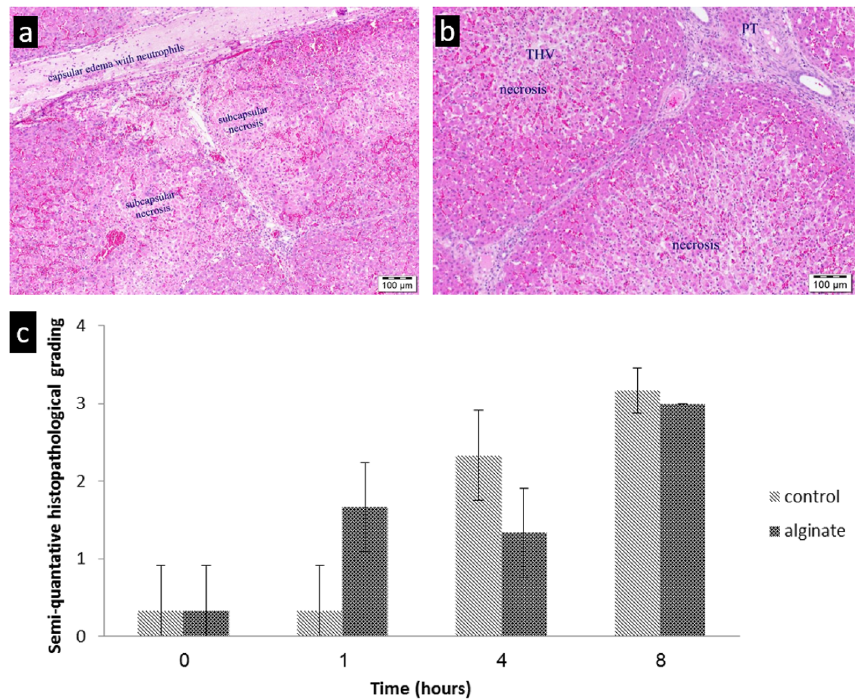
Figure 3. Histologic samples of liver biopsies 8 h after injury. ( a ) alginate-treated animal showing capsular edema and sub-capsular necrosis; ( b ) saline-treated animal showing hepatic lobular necrosis. PT- portal triad, THV- terminal hepatic venule. ( c ) Mean histopathological grading of the liver biopsies, comparing between VLVG alginate and the controls. Biopsies were taken at the beginning (t = 0), and after one hour, 4 h, and 8 h (at the end of the study) from injury. Histopathological changes were scored using semi-quantitative grading (0–4), according to change in severity: 0: No lesion- normal tissue; 1: minimal change; 2: mild change; 3: moderate change; 4: marked change. Each bar represents means ± standard error. n = 3 animals per